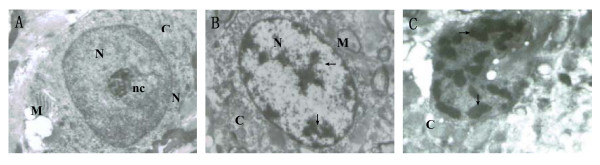
Transmission Electron microscopic evidence of neuronal apoptosis in the ventral horn of the spinal cord. The rabbit spinal cords were fixed by transcardial perfusion and removed at 48 h reperfusion, or operation for sham control and processed as described in Experimental Procedures. A, sham control (magnification × 10000); B-C, I/R control (magnification × 20000). I/R induced neuronal apoptosis, as demonstrated by specific morphological features. No apoptotic neurons were found in sham group sections. N, nucleus; nc, nucleolus; C, cytoplasm; M, mitochondria. Figures are representative of 3 separate experiments with similar results.